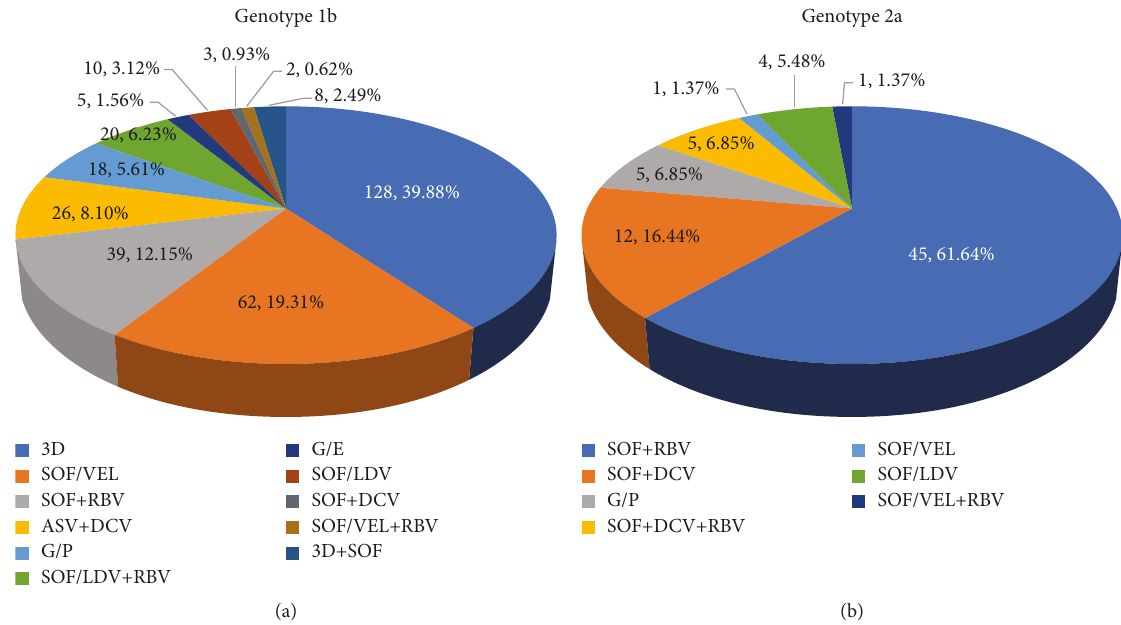
Figure 3: DAAs regimens for HCV genotype 1b and 2a in the real-world study. The number and proportion of different DAAs regimens for HCV genotype 1b (a) and 2a (b) are presented by different colors in the graphs. DAAs: direct-acting antivirals; OBV/PTV/r: